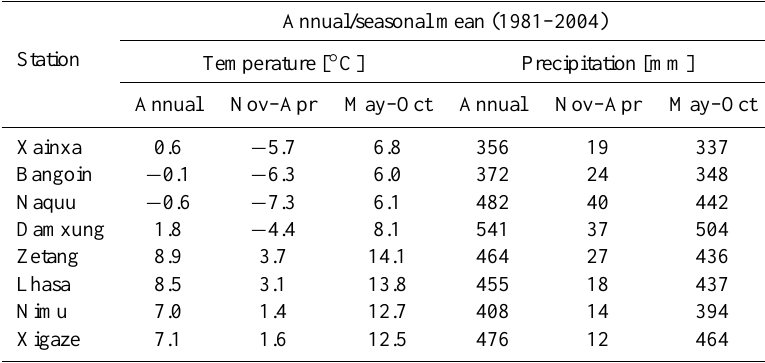
Table 3. Annual and seasonal means of temperature and precipitation measurements for the time period 1981–2004.